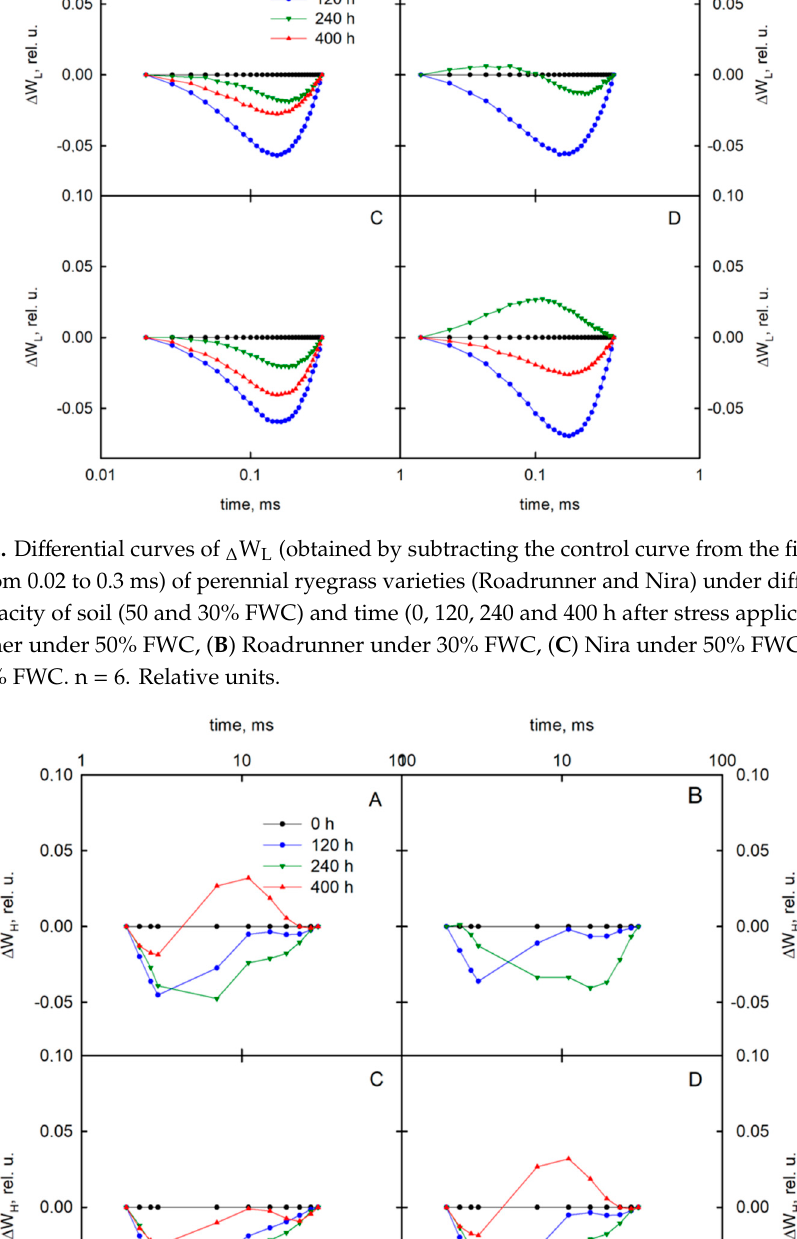
Figure A1. Differential curves of Δ W K (obtained by subtracting the control curve from the first sample in the time from 0.02 to 3 ms) of perennial ryegrass varieties (Roadrunner and Nira) under different field water capacity of soil (50 and 30% FWC) and time (0, 120, 240 and 400 h after stress application): ( A ) Roadrunner under 50% FWC, ( B ) Roadrunner under 30% FWC, ( C ) Nira under 50% FWC, ( D ) Nira under 30% FWC. n = 6. Relative units.